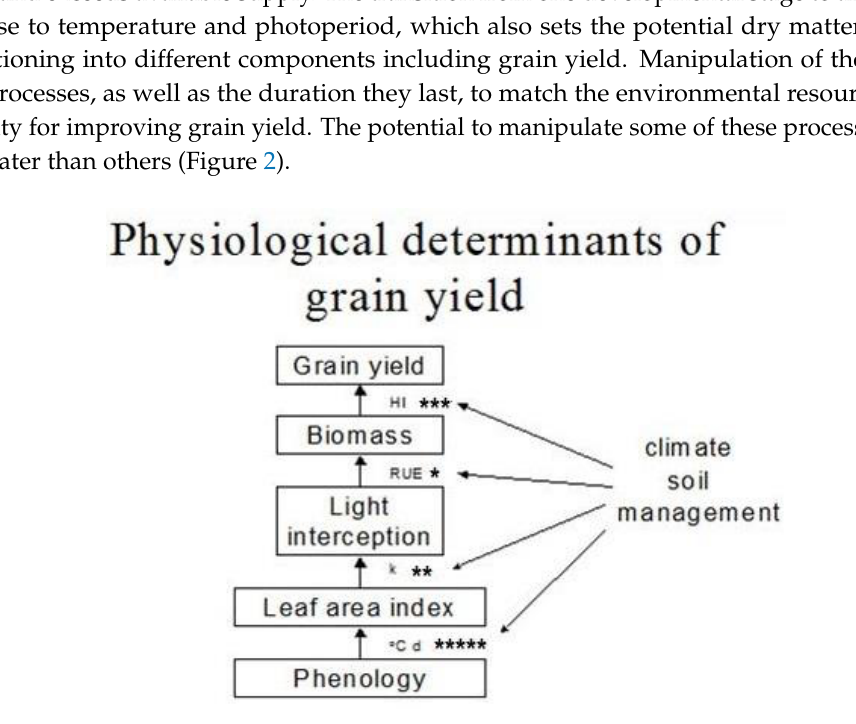
Figure 2. A physiological framework for grain yield in mungbean and the potential for genetic/agronomic manipulation of photo-thermal sensitivity (°C d), light extinction coefficient ( k ), radiation use efficiency (RUE), and harvest index (HI) is compared through the number of asterisks.